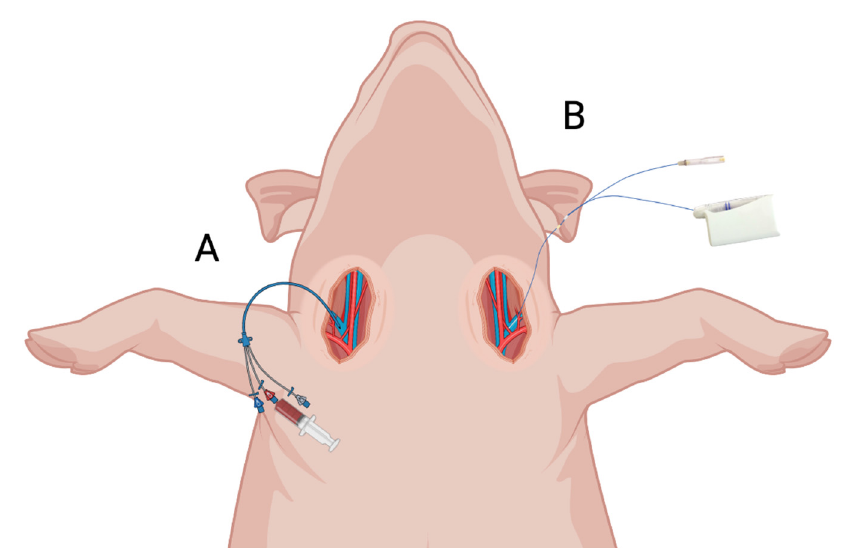
Figure 3. Illustrative drawing of the central venous catheter (A) and placement of the intravenous mi- crodialysis catheter (B). Both drugs were administered through separate peripheral venous catheters placed in both ears of the pig (not illustrated in this figure). Figure 3 was made using Biorender, and permission for publication is obtained